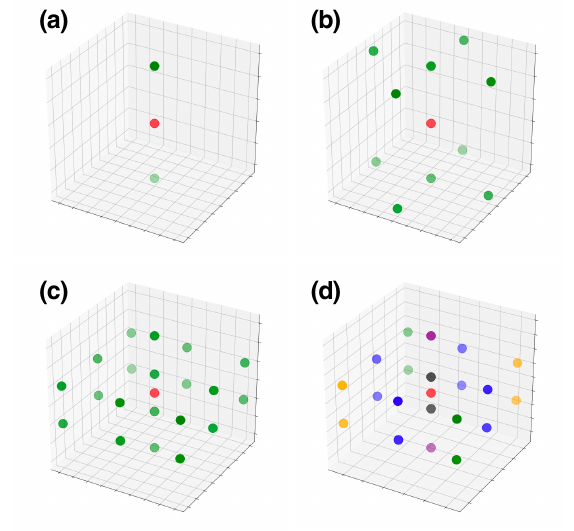
FIG. 4. A selection of geometries investigated for the CaF 2 + μ + system considered in this work. As discussed in the main text, the calcium ions are spin 0 with an abundance of around 99.9%, so we include only the fluorine ions [green in (a)–(c)] and the muon (red) in our simulations. (a) The three spin F- μ + -F system. (b) The 11-spin F- μ + -F system with eight next-nearest- neighbor fluorines. (c) The 21-spin system, which includes the next-next-nearest ten fluorines to the muon. (d) The 21-spin sys- tem, with fluorines grouped by color. The distances between the muon and each fluorine in a given group are the same. When fit- ting simulated data for the 21-qubit system to experimental data, we separately parameterized the F- μ distances according to